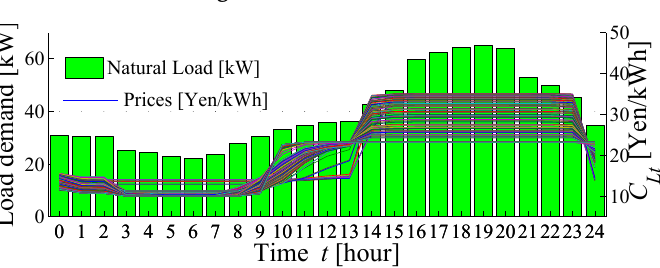
Figure 10. Pareto solution.